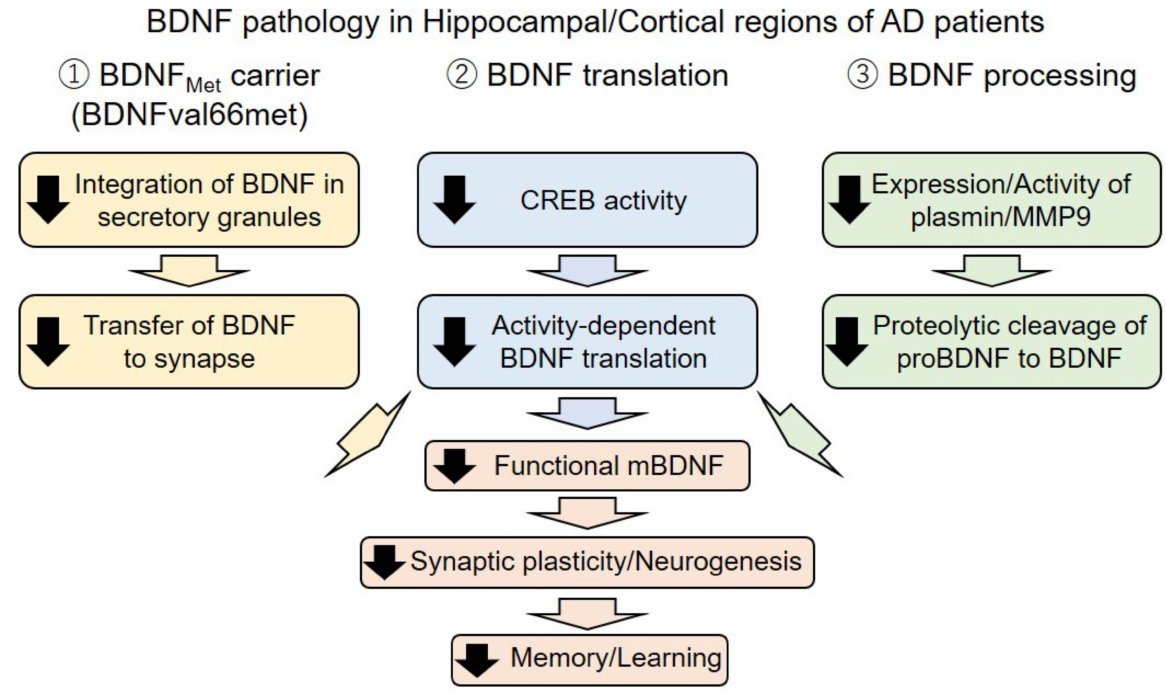
Figure 2. Schematic illustration of dysregulation of the BDNF in Alzheimer’s disease (AD). In the AD brain, mature BDNF (mBDNF) expression is affected by at least three distinct mechanisms, including gene polymorphism (rs6265, BDNF val66met), mRNA translation, and BDNF processing. Through these mechanisms, a reduction of functional mBDNF, impairment of synaptic plasticity/neurogenesis, and then significant decline in memory and learning functions are caused. Black arrow: